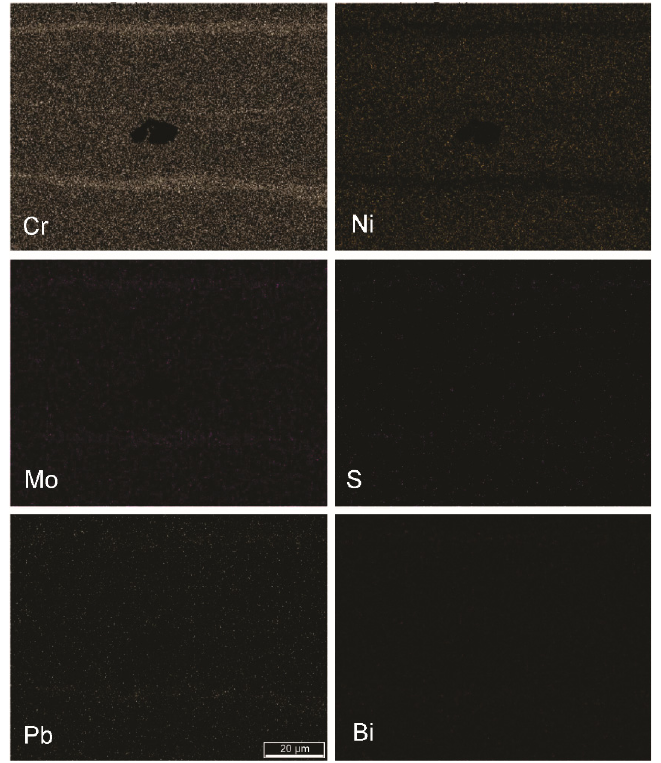
Figure 12. Segregation of Cr, Mo, S, and Pb in the hot-rolled plate of steel R (FE-SEM-EDS mapping; mag. 1000×).